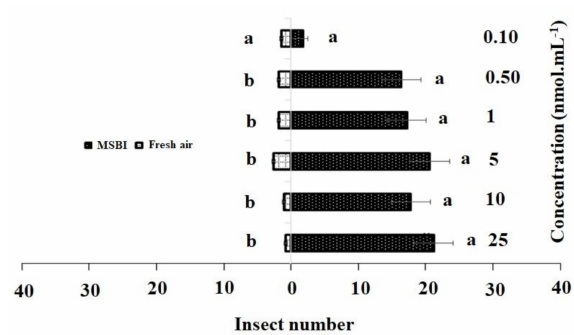
Figure 3. Responses of P. xylostella adult females to synthetic 4-methylsulfinyl-3-butenyl isothiocyanate (MSBI) compared with controls. Bars represent the mean ( ± SE) response of adult female exposed to synthetic active volatile from Barbarea vulgaris plants. Di ff erent letters indicate di ff erences between two treatments at p <